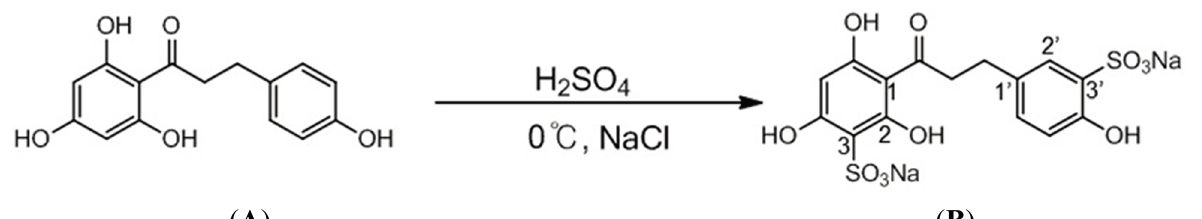
Figure 1. Synthesis reaction from phloretin ( A ) to produce phloretin 3',3-disulfonate ( B